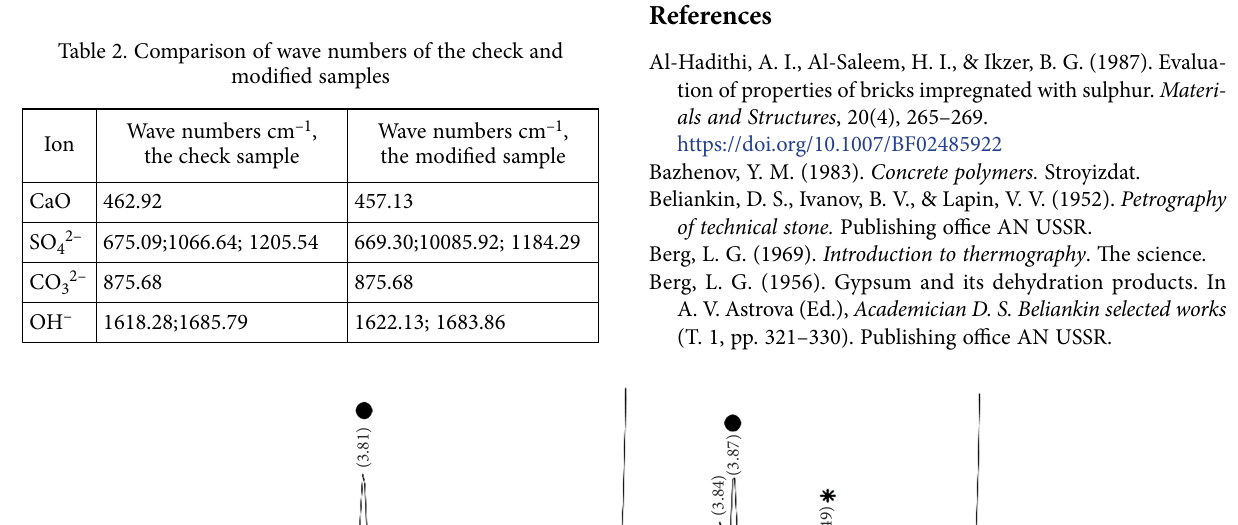
Figure 6. IR spectra of the check (black) and modified sample